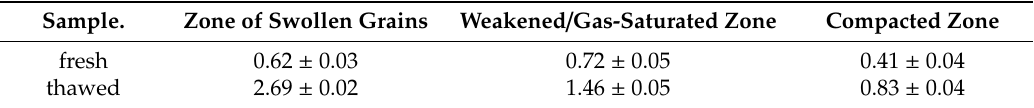
Table 2. The yield of the material extracted from the zones of plastic layer.